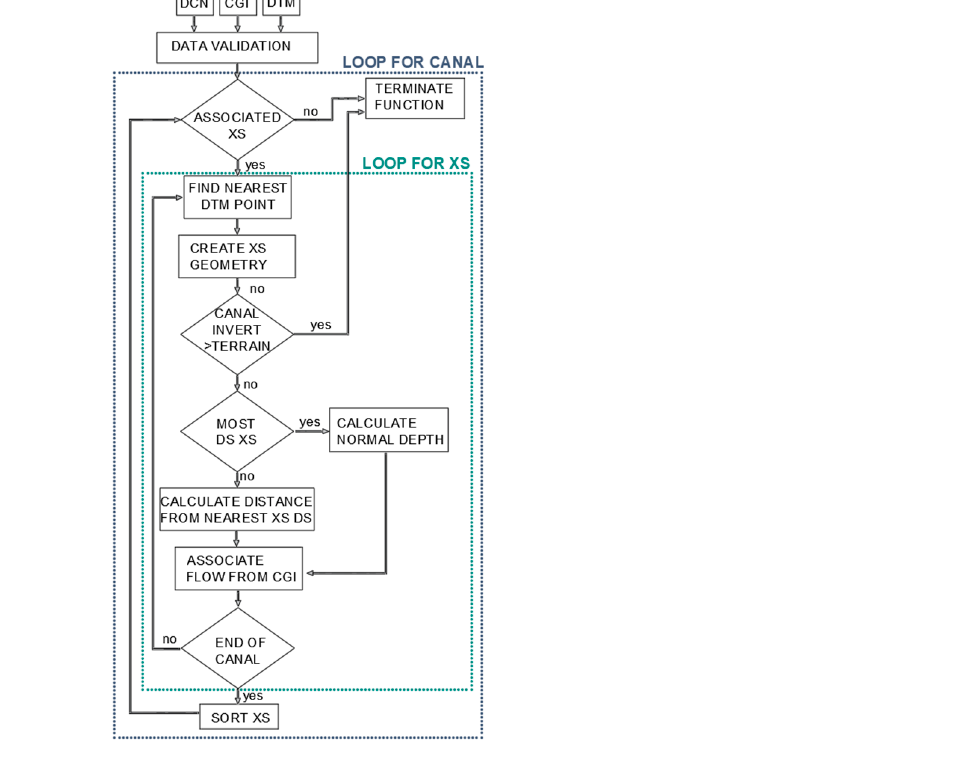
Figure 5. Flow chart of the function block depicting the creation of cross-sectional geometry.